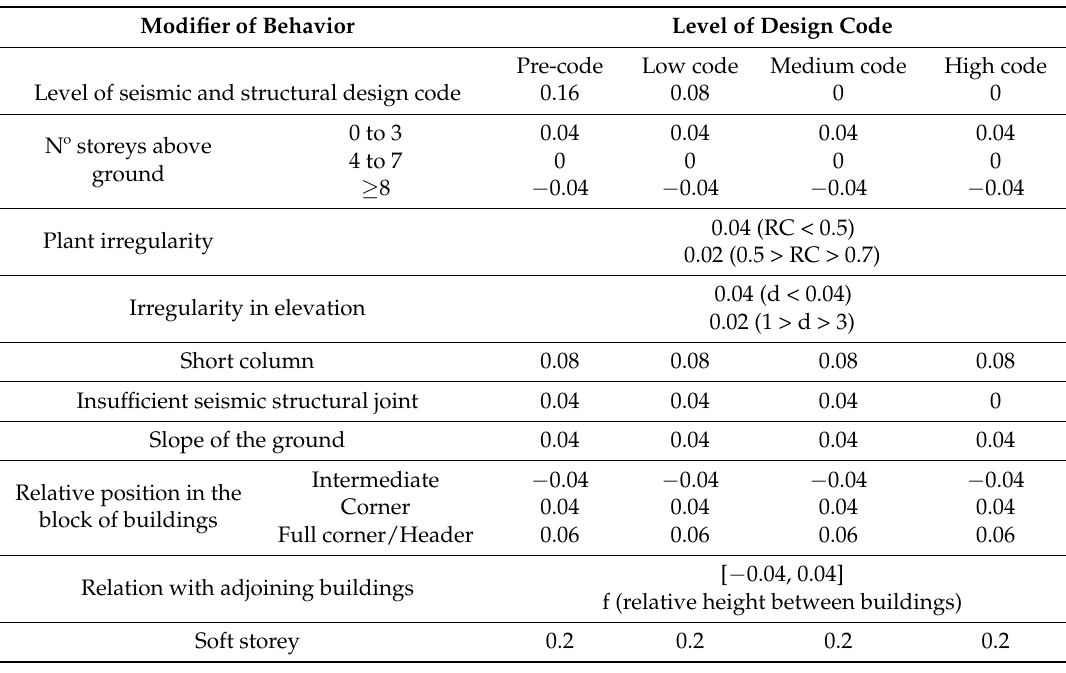
Table 3. Behavior modifiers proposed for the LM1 VIM method, conditioned to the level of the seismic code design assigned. The modified values are indicated in bold. Further description of each element can be found in